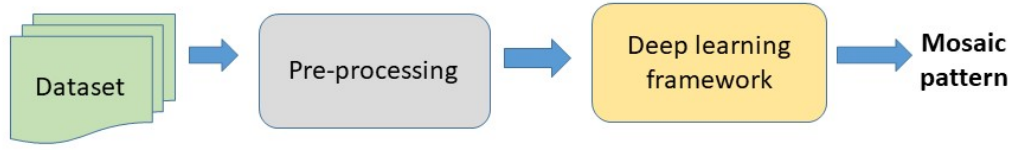
Figure 1. The workflow of the proposed method.